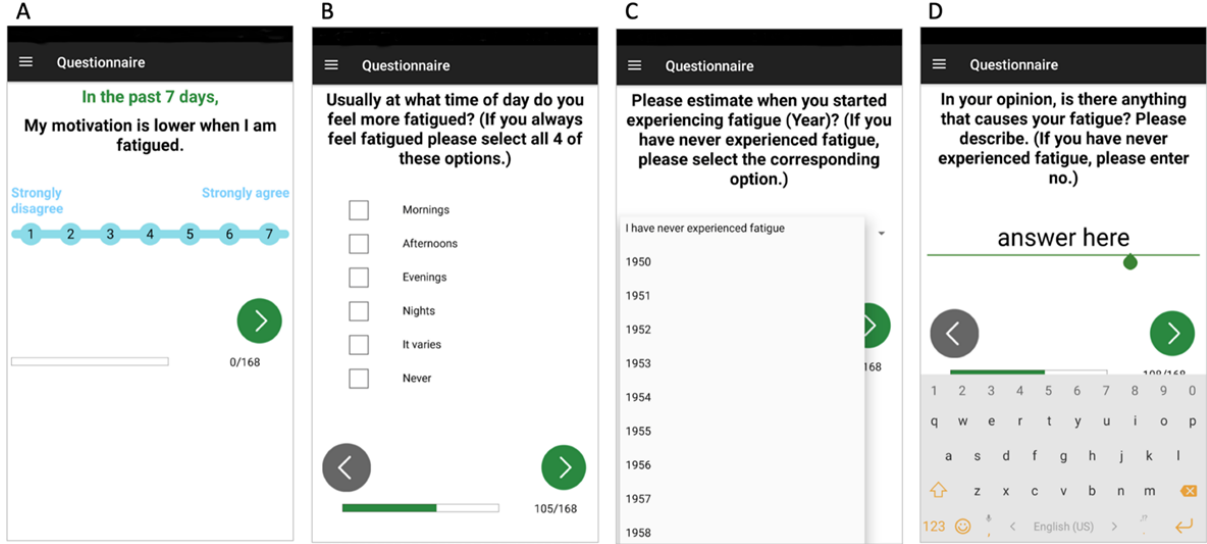
Figure 1. Sample screens for simple choice (A), multiple choice (B), number box (C), and text box (D) questions used in the one-time questionnaire module. Users can freely navigate forward and backward between questions within the same block using the forward (green) and backward (gray) arrows at the bottom of the screen. Under the arrows, a status bar indicates how far through the one-time questions a user is.